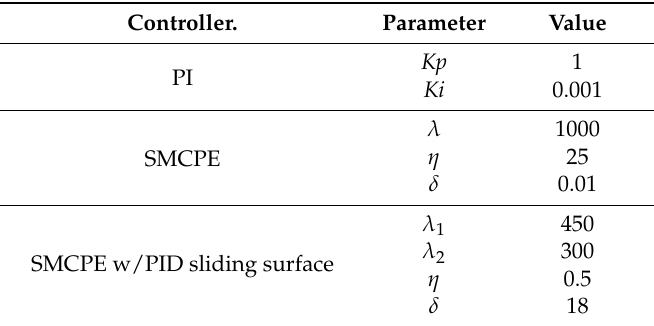
Table 2. Values of the parameters of the